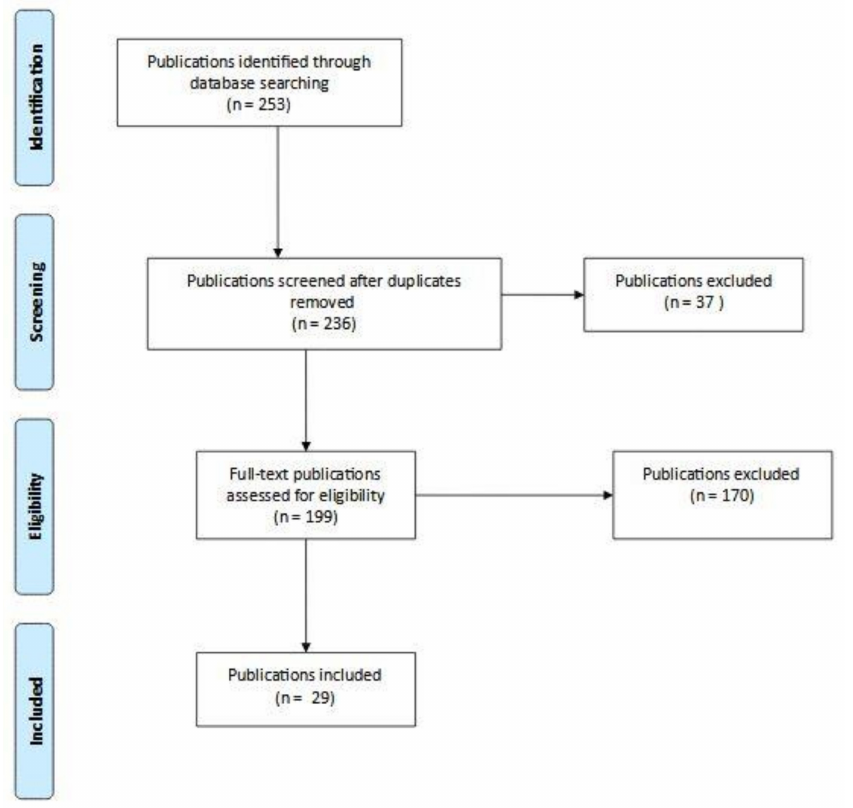
Figure 2. PRISMA flow diagram summarizing the study